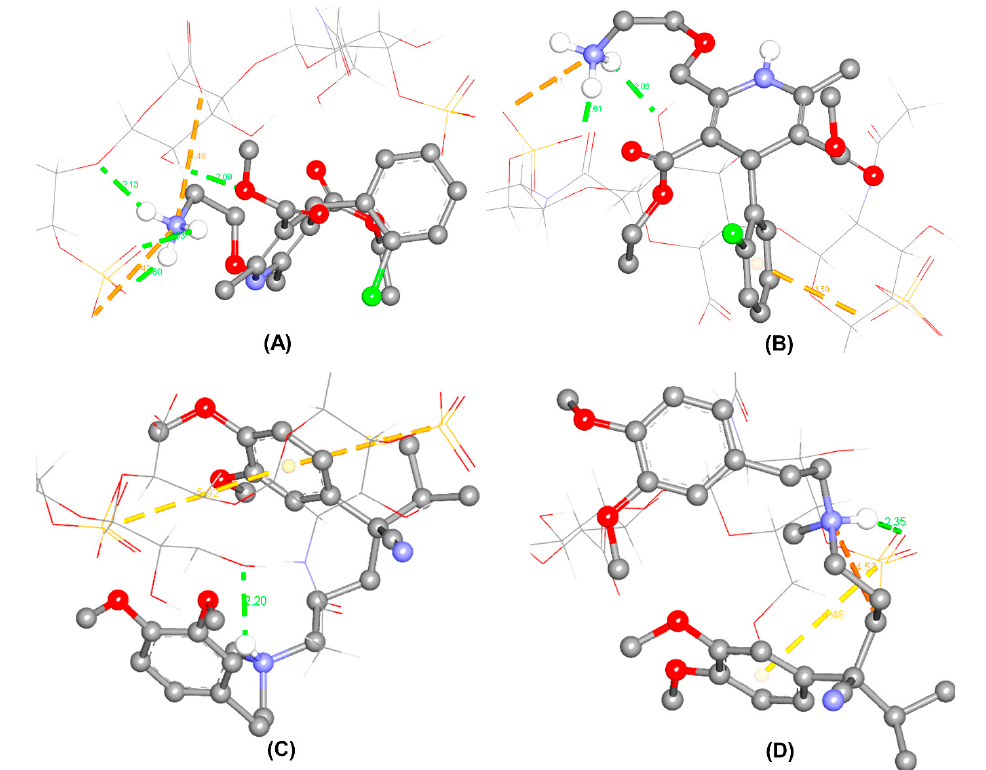
Figure 4. Prediction of the most stable complexes between CSA and the enantiomers of amlodipine and verapamil. CSA is drawn in the wire form and enantiomers are illustrated in the ball-stick form as R -(+)-amlodipine ( A ); S -( − )-amlodipine ( B ); R -(+)-verapamil ( C ); S -( − )-verapamil ( D ). Green dotted lines represent hydrogen bonds; yellow and orange dotted lines represent 𝜋 -sulfur interactions and electrostatic interactions, respectively. The numbers indicate the distances between two functional groups in the predicted interactions.